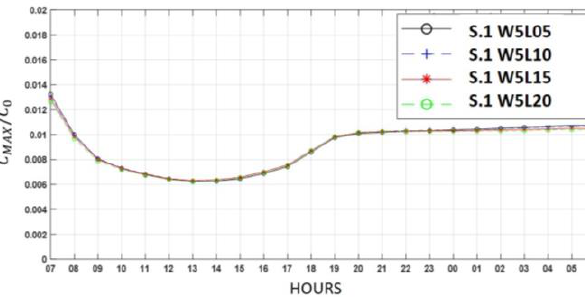
Fig. 8. Daily variation of the nondimensional maximum CO concentration C MAX /C 0 inside the street 1, for the different simulated courtyard